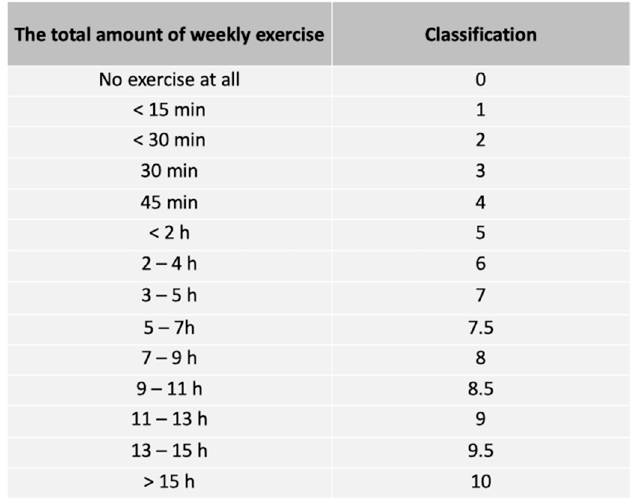
Figure 3. The physical activity classification.